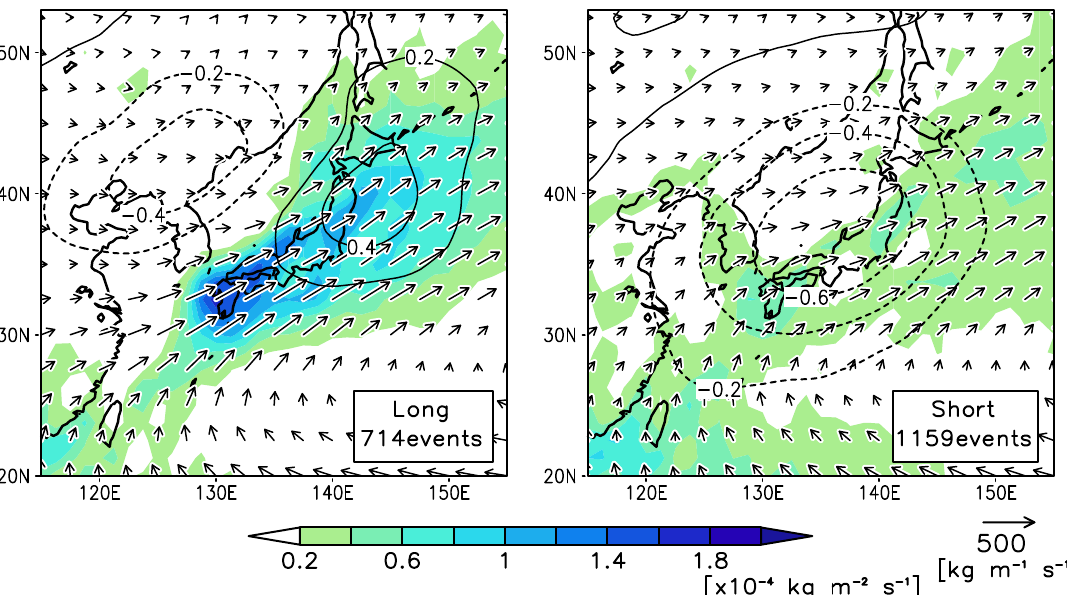
Fig. 2 Mean synoptic weather patterns corresponding to extreme precipitation events. The patterns of vertically integrated moisture fl ux (vector) and its convergence (shading) and temperature anomalies at 500 hPa (contours) for a long- and b short-duration events. Extreme precipitation events are de fi ned as days above the 99th percentile of event peak intensity at any station for each analysed temperature bin. The number of events is indicated at the lower right of each panel. The temperature anomalies indicate the deviation of temperature in the extreme events from monthly mean climatology (1994 – 2018). Moisture convergence >0.2 × 10 − 4 kg m − 2 s − 1 is shaded. The contour interval for temperature anomalies is 0.2 °C and the zero line is omitted.